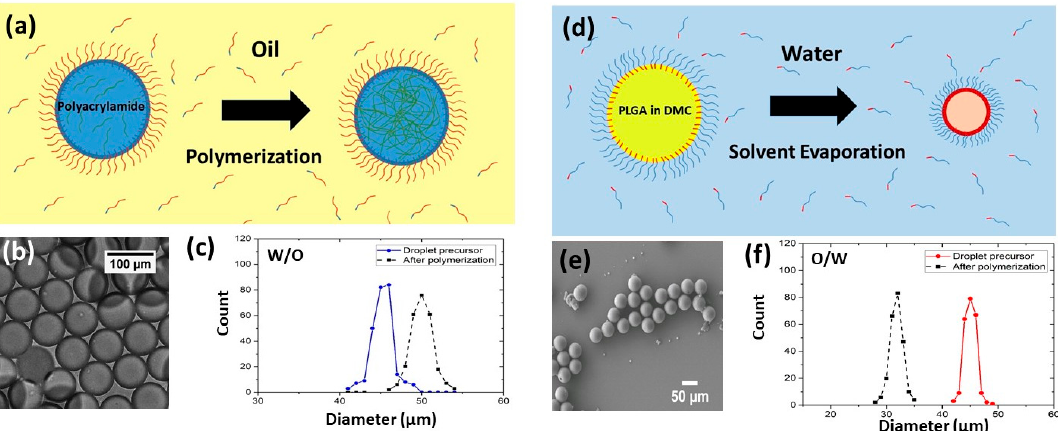
Figure 5. Synthesis of microspheres using both W / O and O / W emulsion templates. ( a ) Schematics of the polyacrylamide synthesis using W / O emulsion droplets. ( b ) A micrograph of the polyacrylamide hydrogel beads after polymerization. ( c ) The size distribution of the polyacrylamide hydrogel microparticles before and after polymerization. ( d ) Schematics of the Poly (l-lactide-co-glycolide) (PLGA) synthesis using O / W emulsion droplets. ( e ) A scanning electron microscope image of PLGA microparticles after the solvent evaporated. ( f ) The size distribution of the PLGA particles before and after polymerization and solvent evaporation.